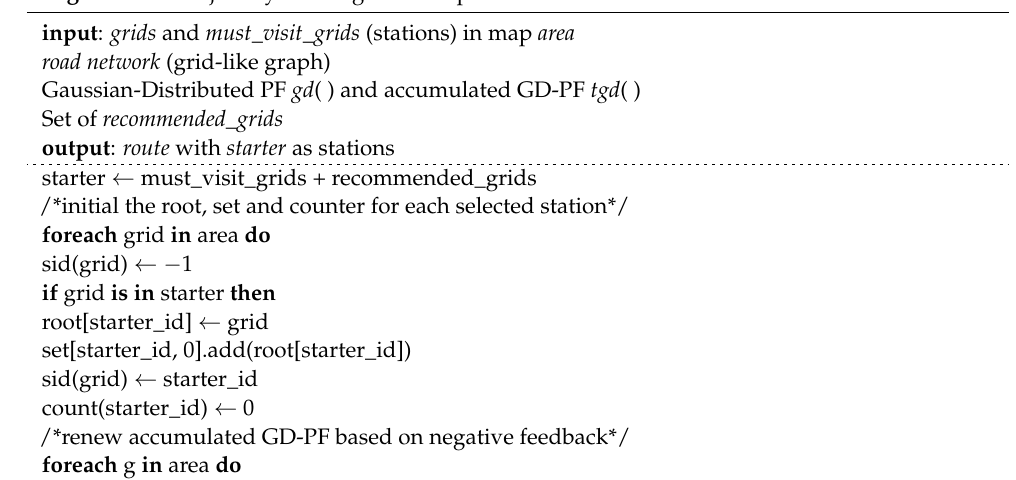
Algorithm 3: Trajectory-Routing for